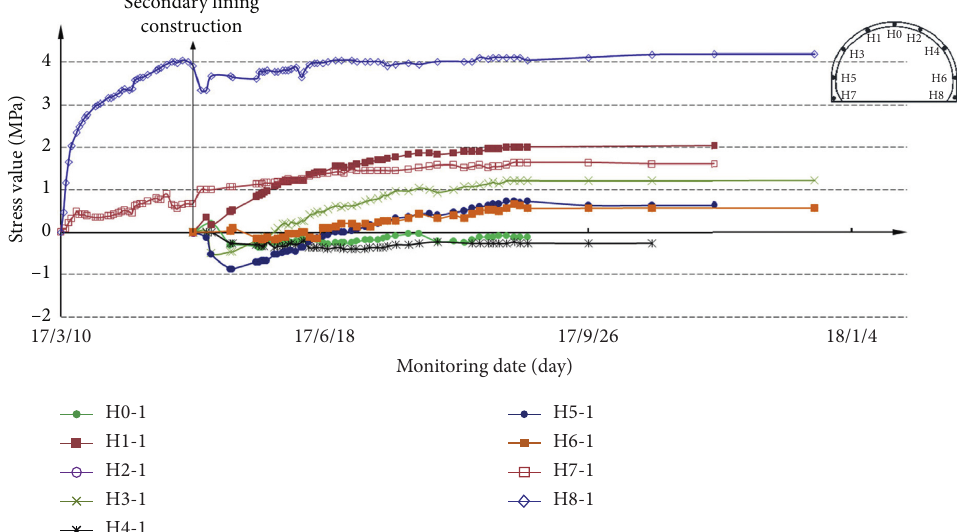
Figure 17: Lateral temporal curve of secondary lining concrete at section